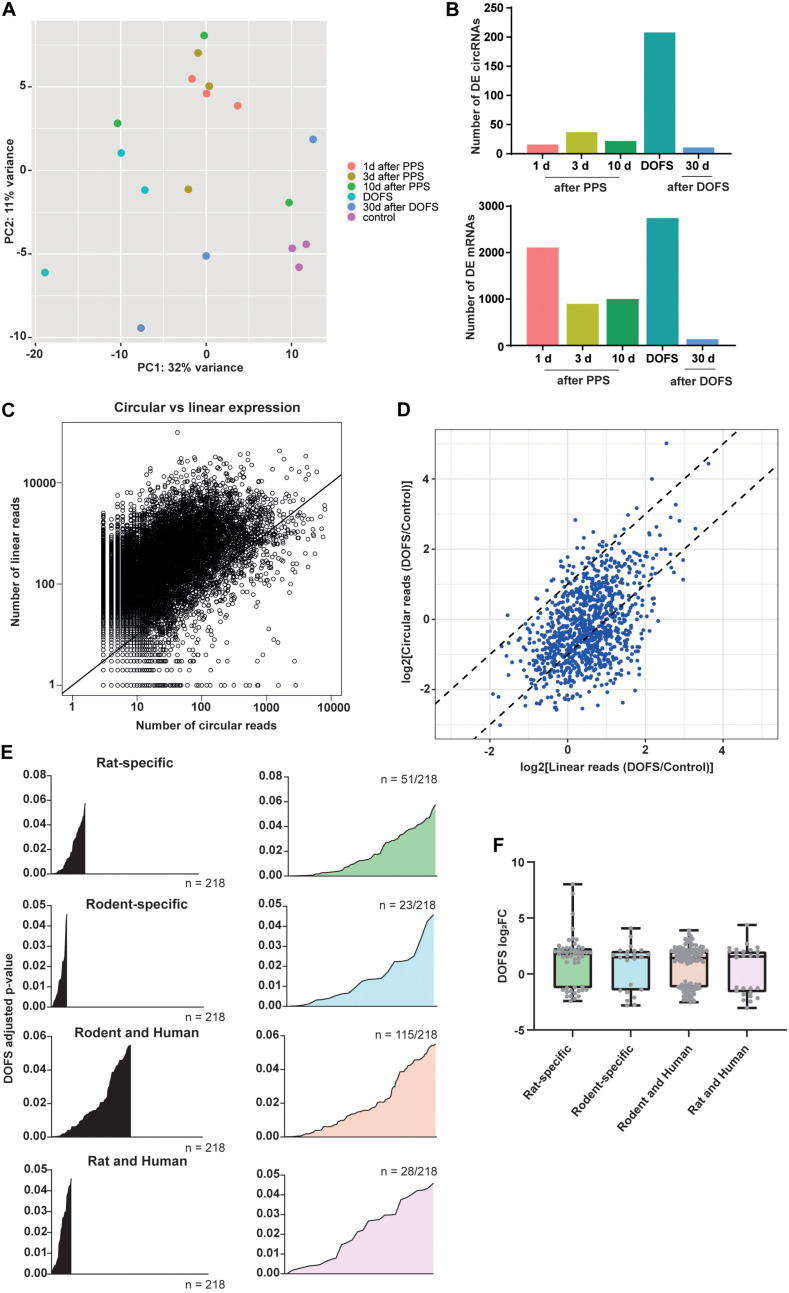
Transcriptome characterization at DOFS. (A) Principal component analysis (PCA) of the different experimental groups based on the transcriptome changes of the 1000 most highly expressed circRNAs. (B) Number of differentially expressed circRNAs (upper panel) and mRNAs (lower panel) at the six experimental time points (p < 0.05) (DE, differentially expressed). (C) Scatter plot showing the comparison of circRNA and mRNA expression. The x-axis shows the number of reads mapped across the back-splice junction (BSJ) for each detected circRNAs; the y-axis shows the number of linearly spliced reads from the corresponding splice acceptor and splice donor sites. Each dot represents one host gene and corresponding circRNA expression. The diagonal black line separates circRNAs that are expressed lower than linear host gene transcripts (above the line) from circRNAs that are expressed higher than linear host gene transcripts (below the line). (D) Circular and linear transcript regulation at the DOFS. Axis represent the DOFS/Control ratio for linear (x-axis) and circular (y-axis) reads. Each dot depicts one circRNA. Dotted lines indicate twofold changes (–2 to 2) and show if differences between control and DOFS impact linear and circular expression equally (in between the two dotted lines) or independently (outside the two dotted lines). (E) Statistical significance distribution of the 218 significantly deregulated circRNAs within the three conservation classes (rat-specific = 51/218, rodent-specific = 23/218, rodent and human = 115/218, rat and human = 28/218). (F) Distribution of the log2FC values of the 218 significantly deregulated circRNAs within the three conservation classes (rat-specific, rodent-specific, rodent and human, rat and human). Each dot depicts one circRNA (log2FC, log2fold-change).